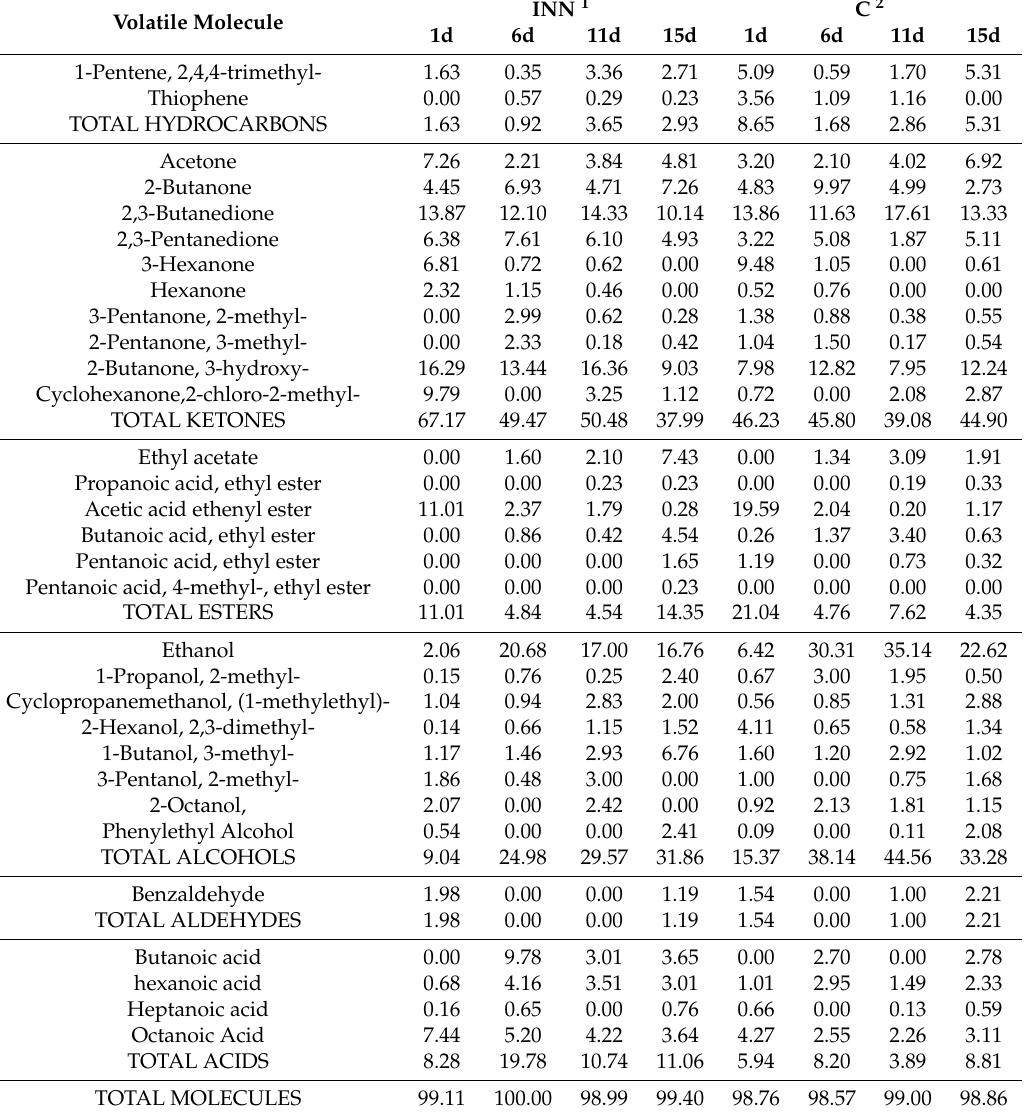
Table 5. Volatile compounds (expressed as relative percentages) detected through the GC-MS-SPME technique in innovative (INN) and traditional (C) Squacquerone cheeses after 1, 6, 11, and 15 days of storage. In the same line, relative to each FFA, means ± SD followed by di ff erent superscript letters are significantly di ff erent, p <